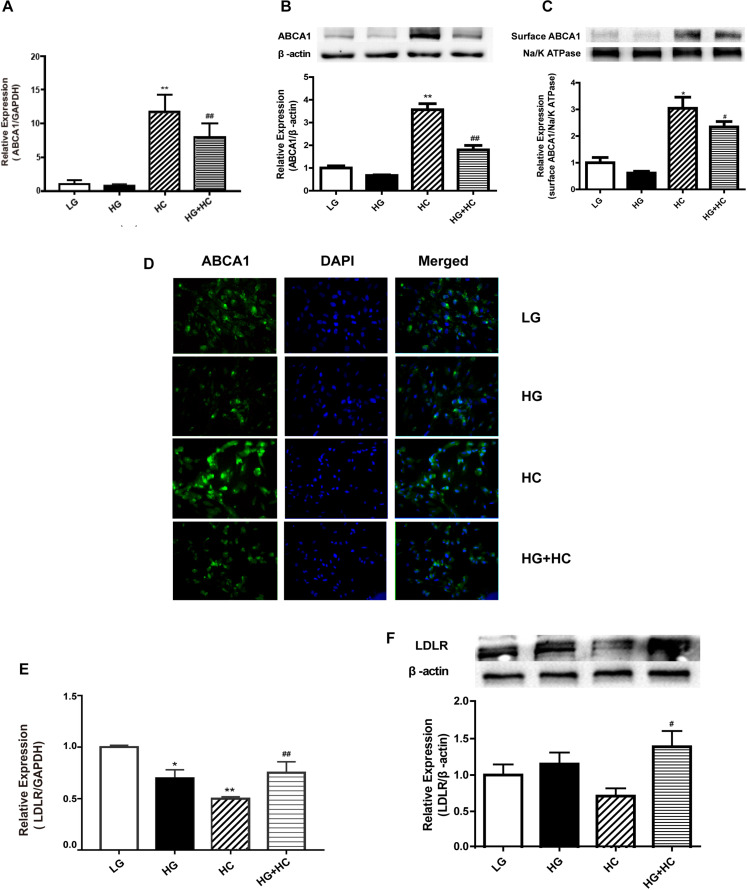
HG interferes with cell responses to excess cholesterol by affecting the expressions of ABCA1 and low-density lipoprotein receptor (LDLR). (A) RT-qPCR analysis to determine ABCA1 mRNA expression (**P < 0.01 vs. LG; ##P < 0.01 vs. HC). (B,C) WB analysis to determine total ABCA1 and surface protein expression (*P < 0.05 vs. LG; #P < 0.05 vs. HC). (D) Immunofluorescence experiment was conducted to determine the expression of ABCA1. (E,F) RT-qPCR and WB analyses were conducted to determine LDLR expression (*P < 0.05 vs. LG; **P < 0.01 vs. LG; #P < 0.05 vs. HC; ##P < 0.01 vs. HC).